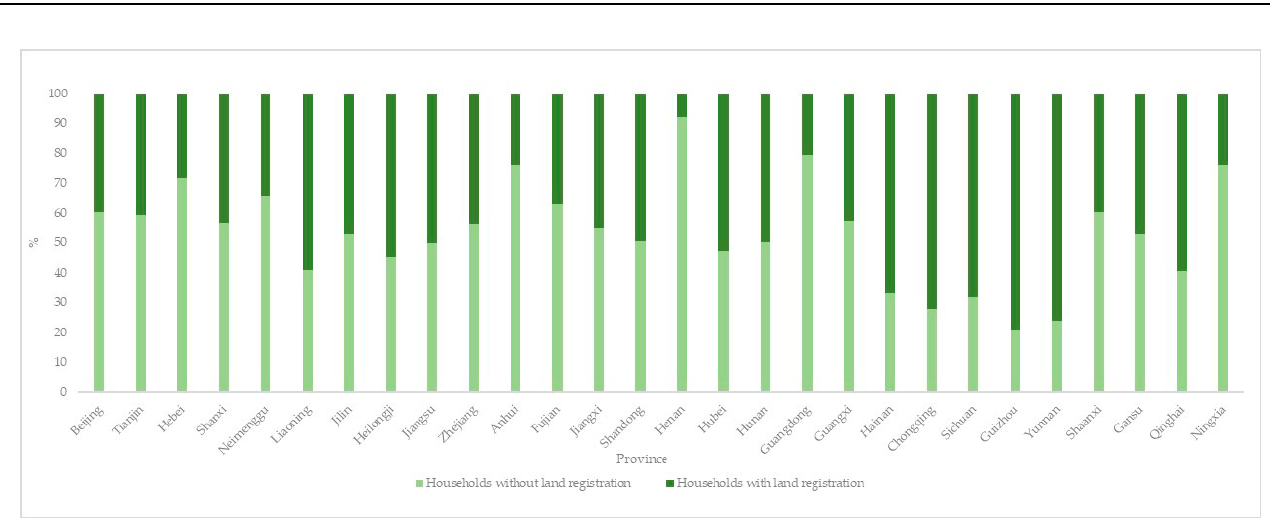
Figure 5. Land registration proportion in various provinces in rural China.